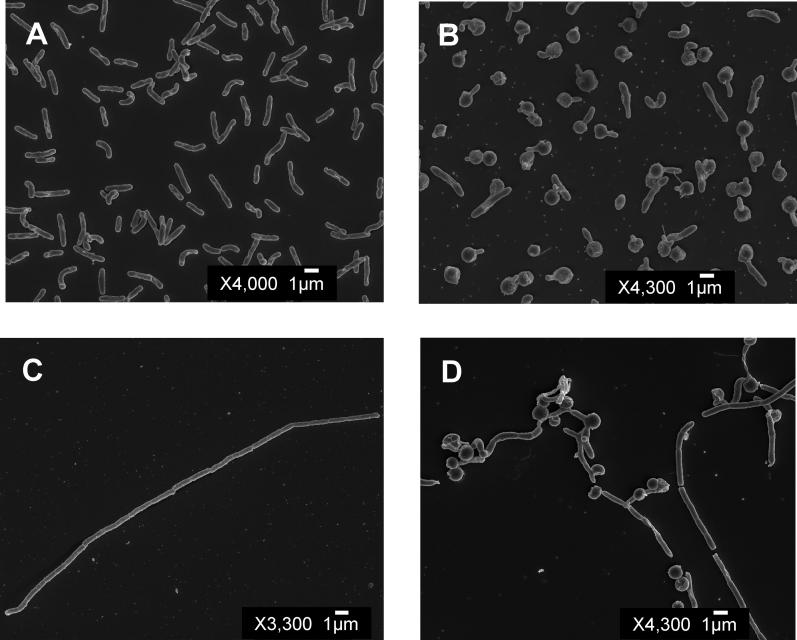
Effect of Amoxicillin on H. pylori MorphologySEM of H. pylori strain 26695 (A and B) and its isogenic amiA mutant (C and D) grown without amoxicillin (A and C) and after 3–4 h exposure to 10 μg/ml amoxicillin (B and D). Amoxicillin treatment of the amiA mutant bypasses the requirement of amiA for the morphological transition, indicating that absence of coccoid forms was not due to sterical hindrance of the bacterial chains.